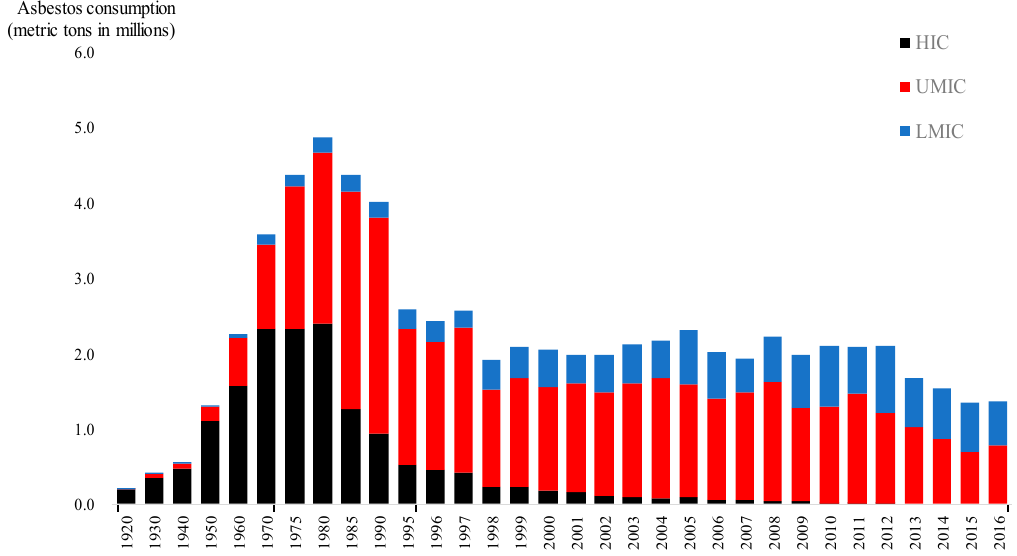
Figure 3. Global Trend Over Time in Asbestos Use of the 3 Country Groups based on National Income Category. HIC: High income countries (N = 54), UMIC: Upper middle-income countries (N = 51); LMIC: Lower middle income and low-income countries combined (N = 57). See Table 2 and text for exact definition of national income category. USGS reported world asbestos consumption with 10- and 5- year interval during 1920–1970 and 1975–1995, respectively, and every single year since